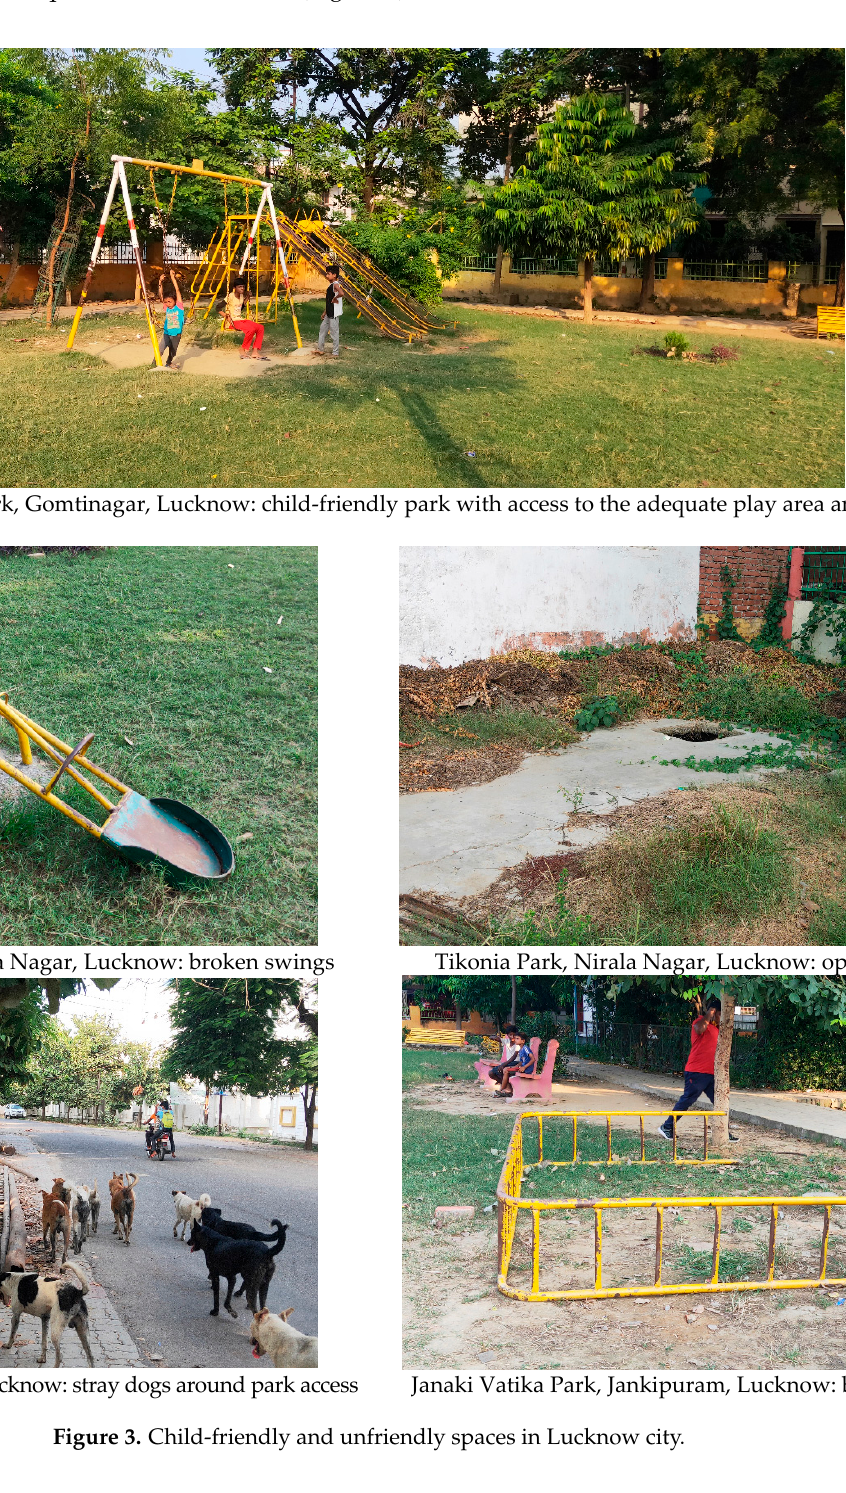
Figure 2. Regional Open/Green Spaces, Lucknow City